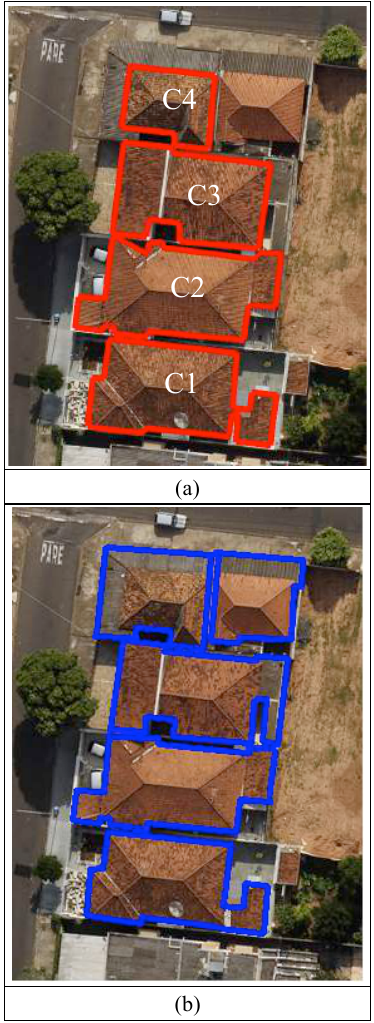
Figure 4. Test 2. (a) Building roof polylines identified by the GA algorithm; (b) Reference building roof